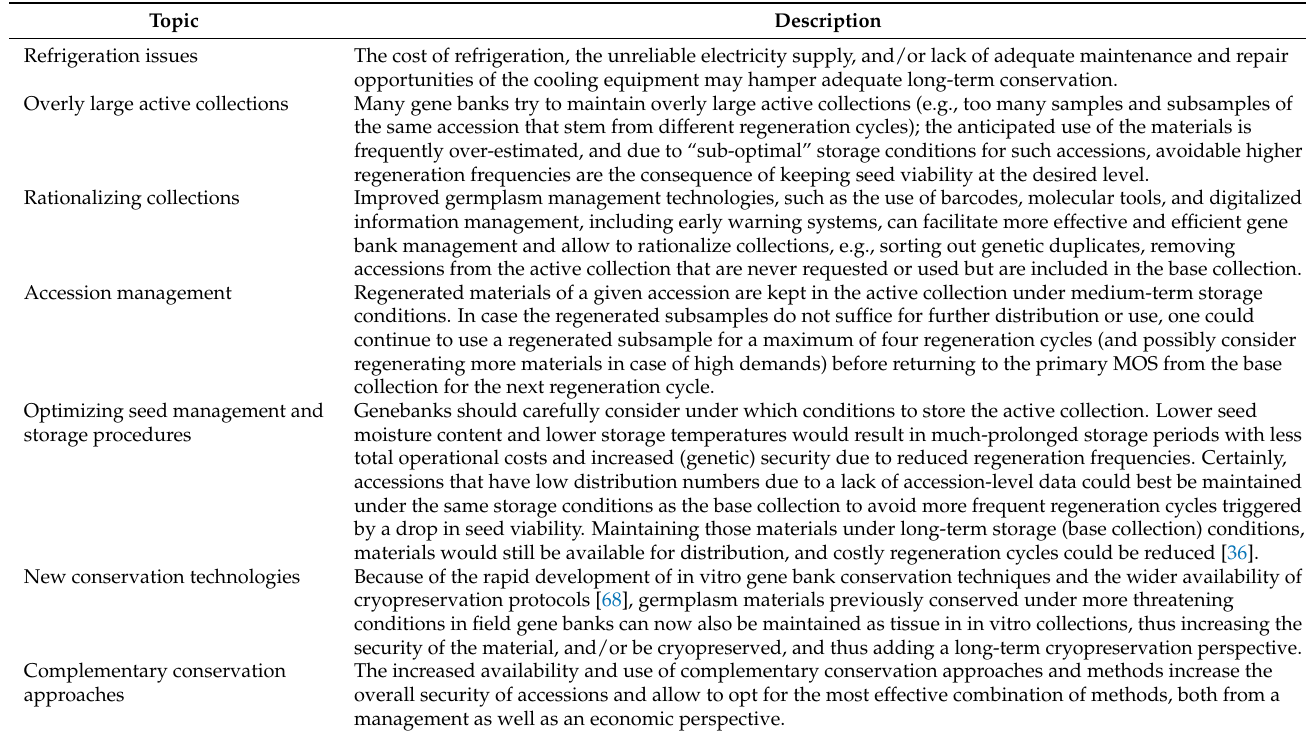
Table 2. Reasons for adjustments and refinements of the concept of active collections to optimize long-term